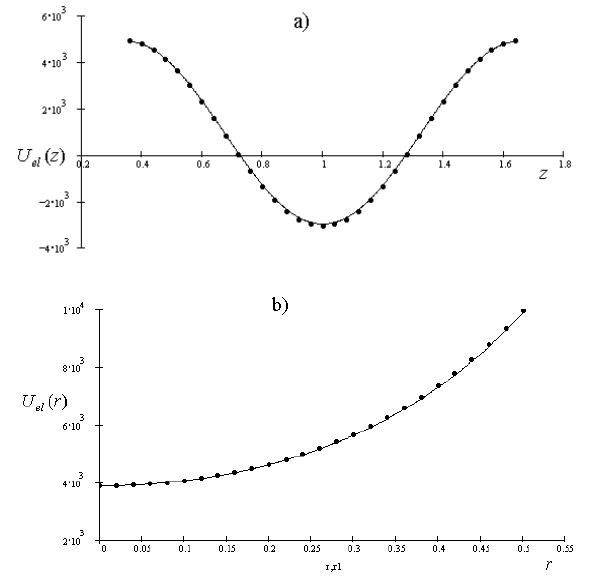
FIG. 3. Example of longitudinal (a) and transverse (b) field potential